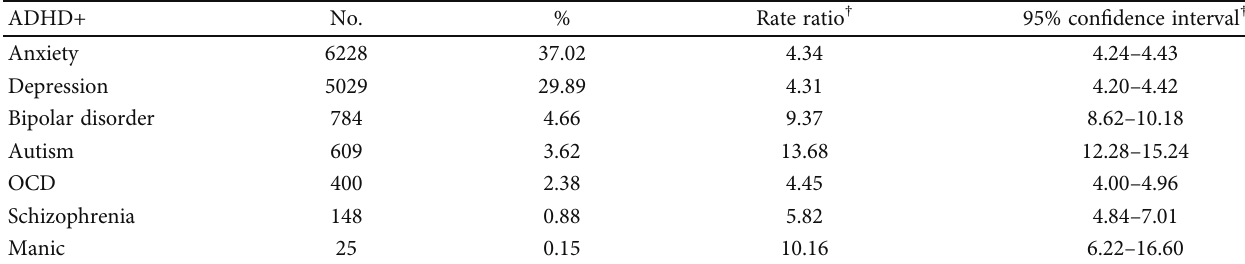
Table 2: Rate of other types of mental health problems among ADHD cases compared with non-ADHD cases.